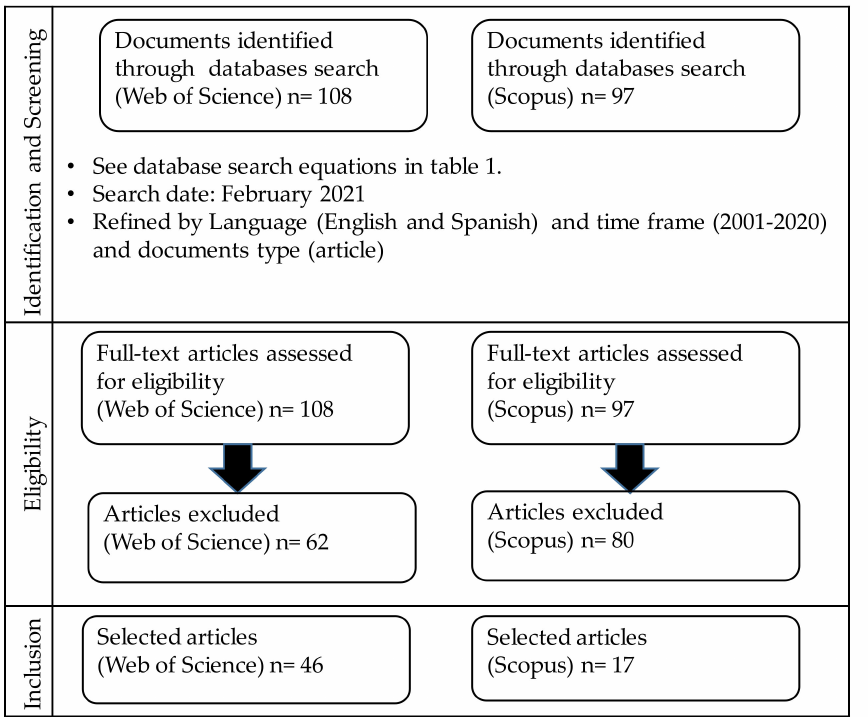
Figure 3. Basic methodological scheme followed in the bibliometric analysis. Source: Own elabora- tion based on PRISMA